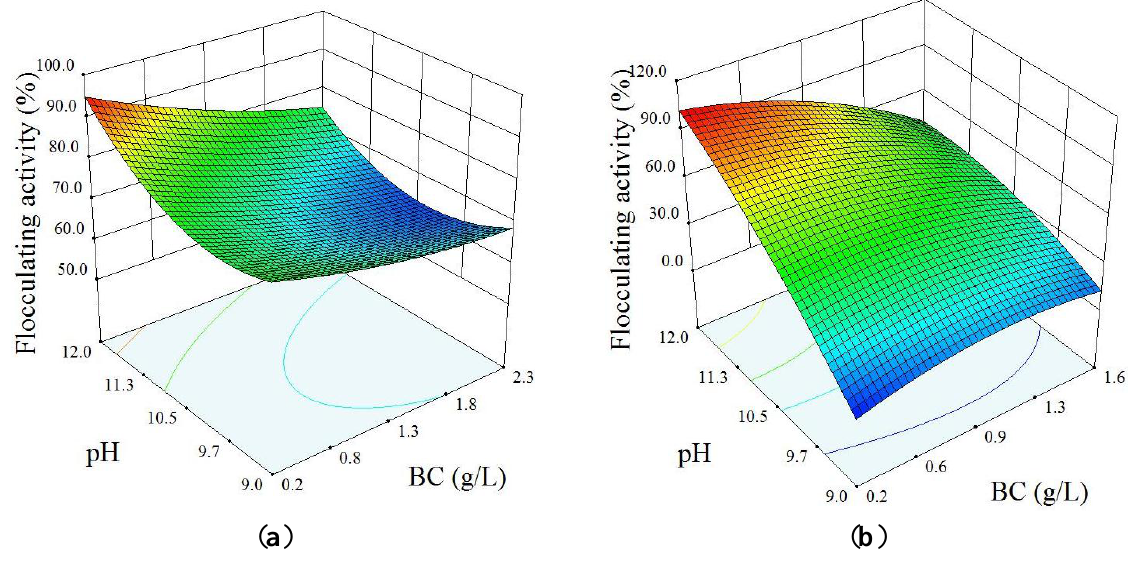
Figure 2. Response surface plot representing effect of pH and biomass concentration